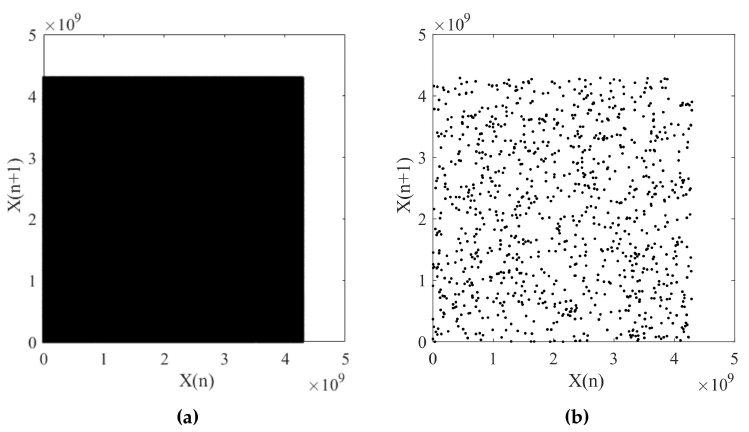
Figure 7. ( a ) Mapping of a sequence X(n) of 3,125,000 samples, generated by the proposed SPCNG and the mapping of 1000 samples taken randomly from X(n) in ( b ).